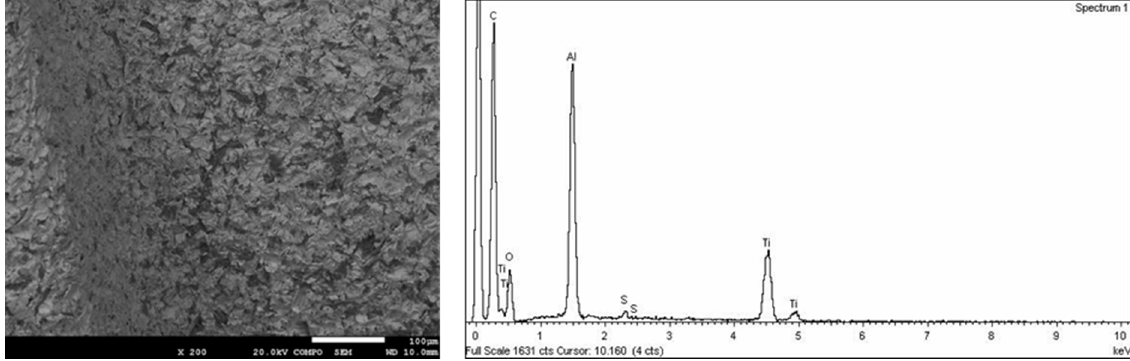
Figure 3. Surface of SB + AE implants observed by scanning electron microscopy and X-ray